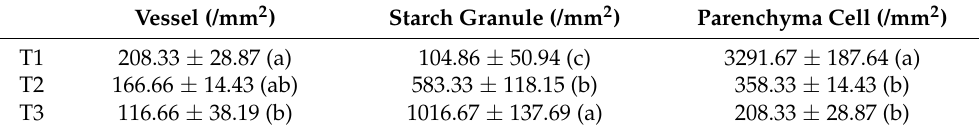
Figure 1. Physiological changes in different developmental stages of SYQ roots. ( A ) Morphology of roots. ( B ) Transverse sections of roots at different microscopic magnifications. Abbreviations: CA, cambium; CT, cortex; PC, parenchyma cell; X, xylem; P, phloem; SG, starch granules. The upward picture is the overall structure of SYQ roots at different developmental stages, and the picture below shows the details of the above image after zooming. Table 1 . Microscopic quantitative analysis of SYQ roots at different developmental stages.